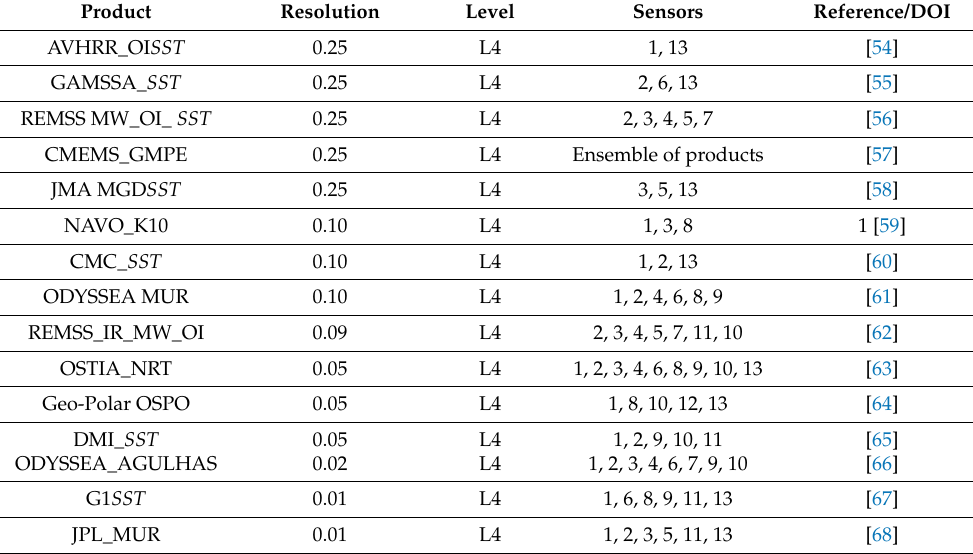
Table 1. Description of the various Level 4 (L4) SST products used in this study, including the low, medium and high-resolution SST products. The numbers representing the sensors used are fully expanded in Table A1 in Appendix A.